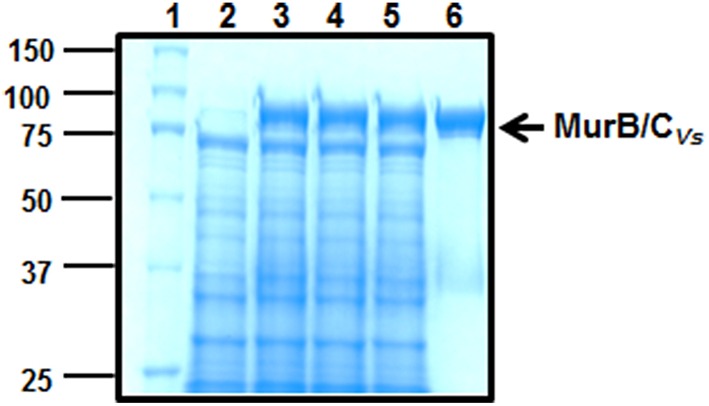
Assay to assess cleavage of MurB/C using a crude protein extract from V. spinosum. Lane (1), protein ladder (kDa). Lane (2), 15 μg of V. spinosum extract. Lane (3), 15 μg of V. spinosum extract plus 7.5 μg of purified MurB/C at time zero. Lane (4), 15 μg of V. spinosum extract plus 7.5 μg of purified MurB/C at 60 min. Lane (5), 15 μg of V. spinosum extract plus 7.5 μg of purified MurB/C at 120 min. Lane (6), 7.5 μg of purified MurB/C. The temperature of the assay was 30°C. The proteins were resolved on a 10% (w/v) acrylamide gel and stained with Coomassie blue for visualization.